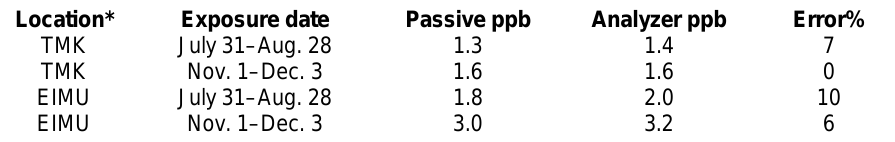
Independent Validation Results of PASS SO